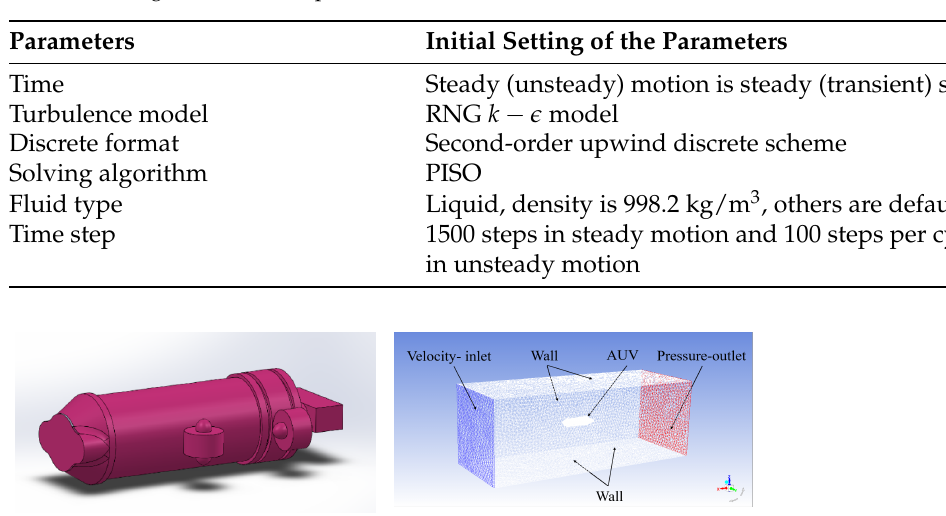
Table 1. Setting of some initial parameters of CFD simulation.